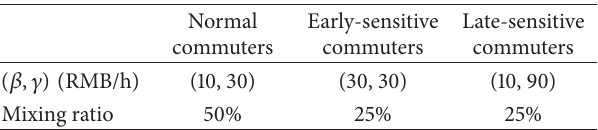
Table 2: Commuter’s early/late arrival penalty coefficients and mixing ratios of different